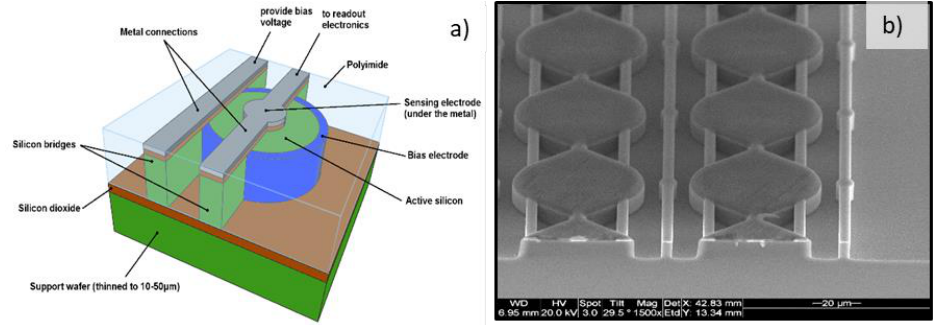
Figure 5. ( a ) Design of the free-standing 3D SV embedded in tissue-equivalent material and ( b ) SEM image of the 3D Mushroom microdosimeter with free-standing 3D SV and surrounding silicon re- moved.